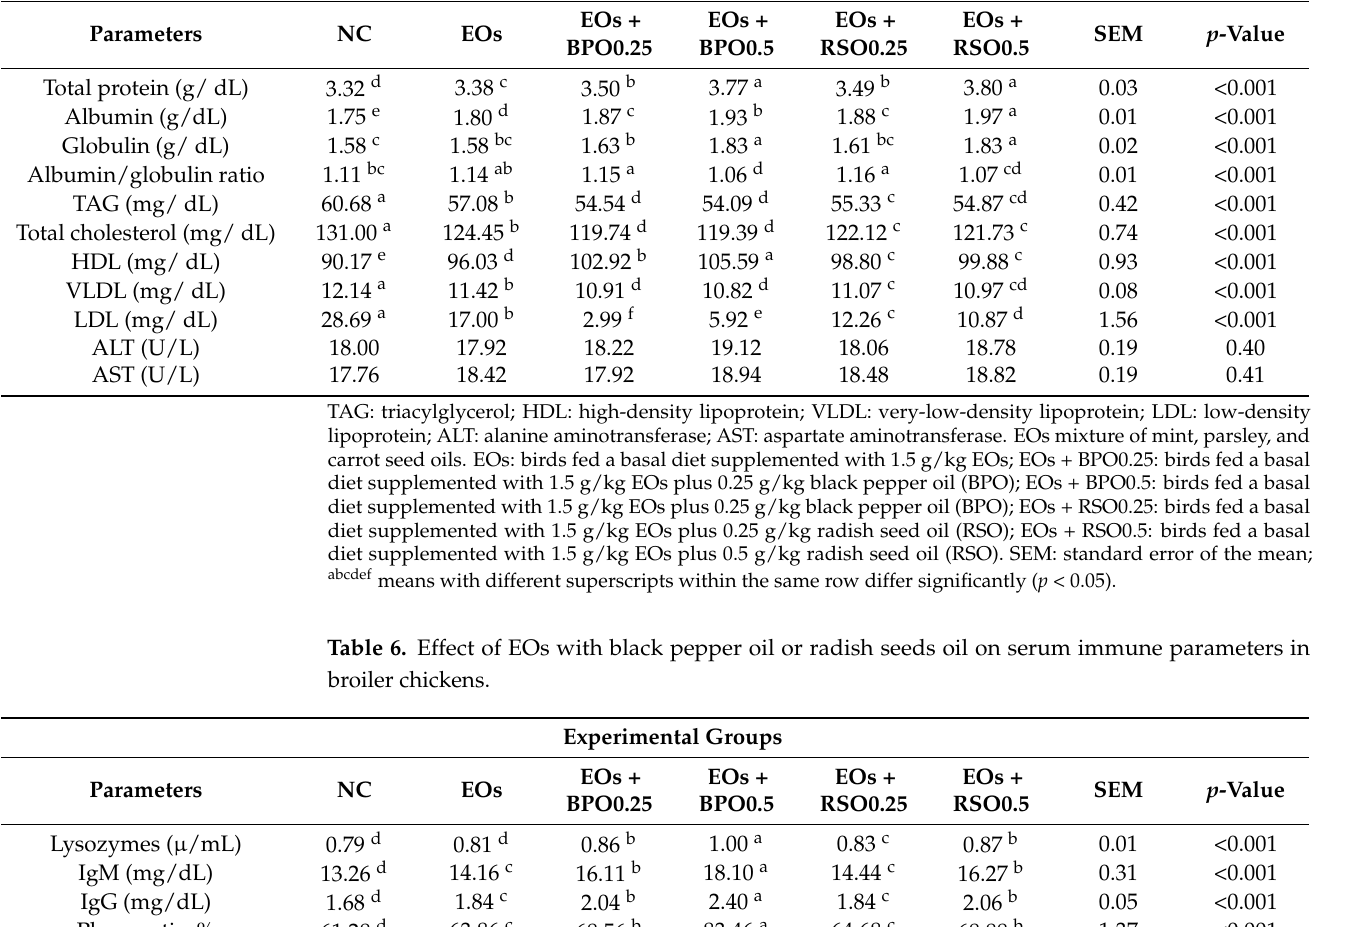
Table 5. Effect of EOs with black pepper oil or radish seeds oil on serum biochemicals in broiler chickens. Experimental Groups